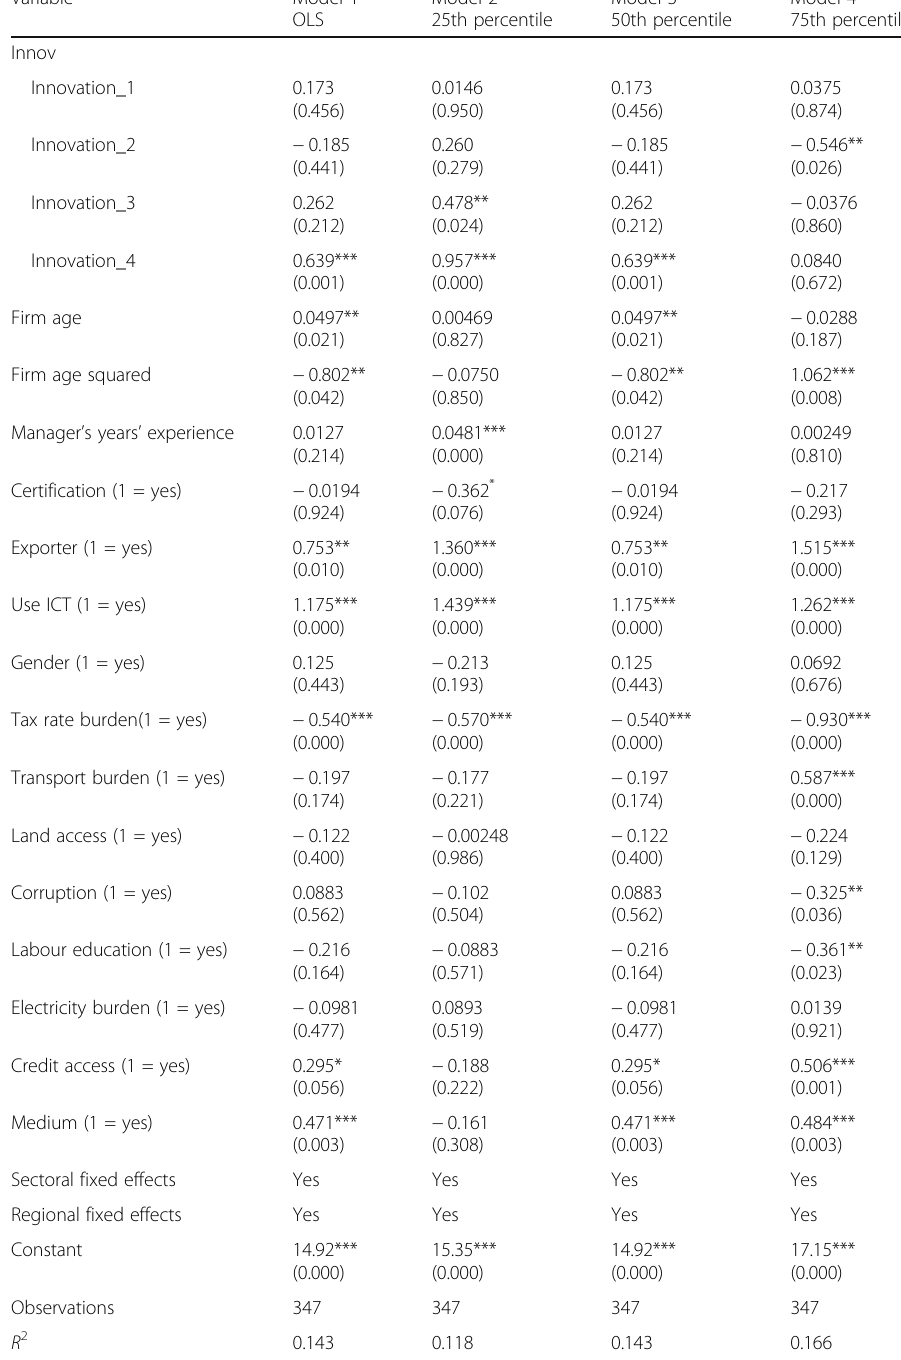
Table 3 Innovation and labour productivity (controlling for firm